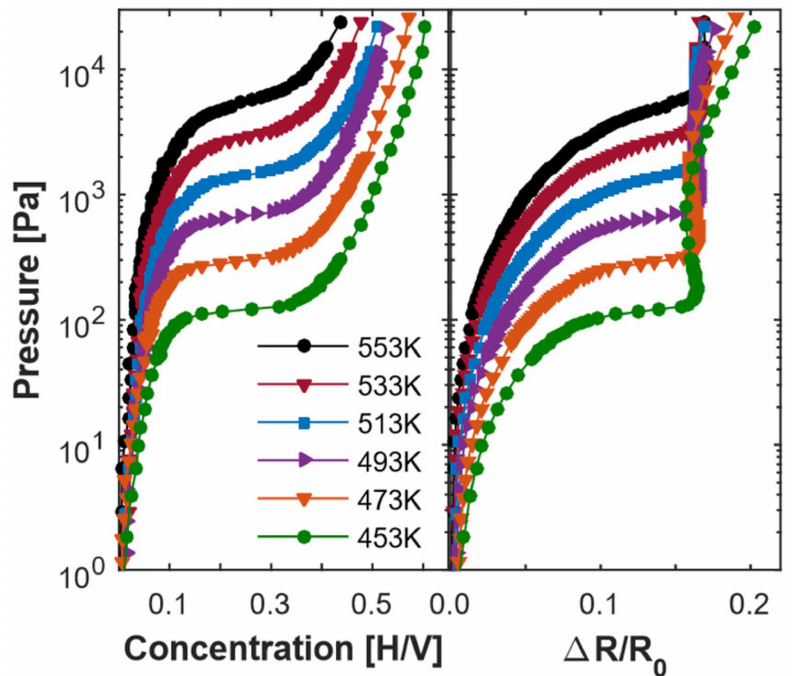
Figure 2. Isotherms of the pressure versus the hydrogen concentration and the excess resistivity of a Cr 3 /V 21